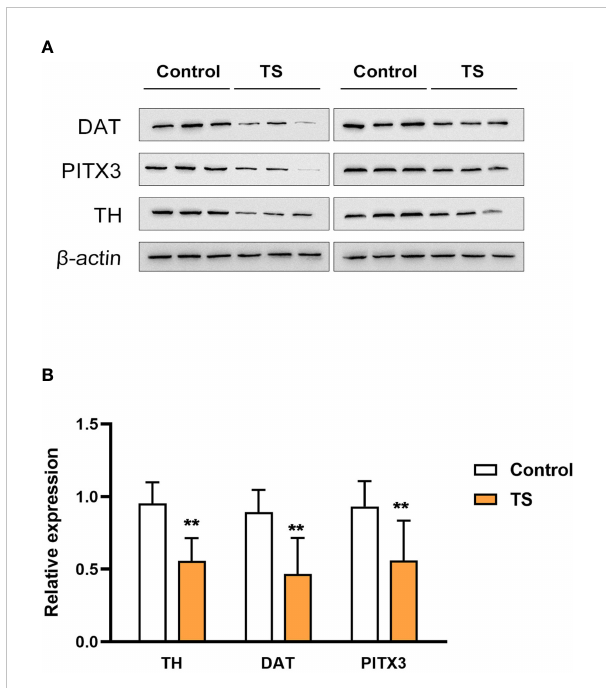
FIGURE 1 The expression of tyrosine hydroxylase (TH), dopamine transporter (DAT), and PITX3 is signi fi cantly decreased in the striatum of the Tourette syndrome (TS) rats. (A) The blots of TH, DAT, and PITX3. (B) The statistical analysis of the protein expression. **P